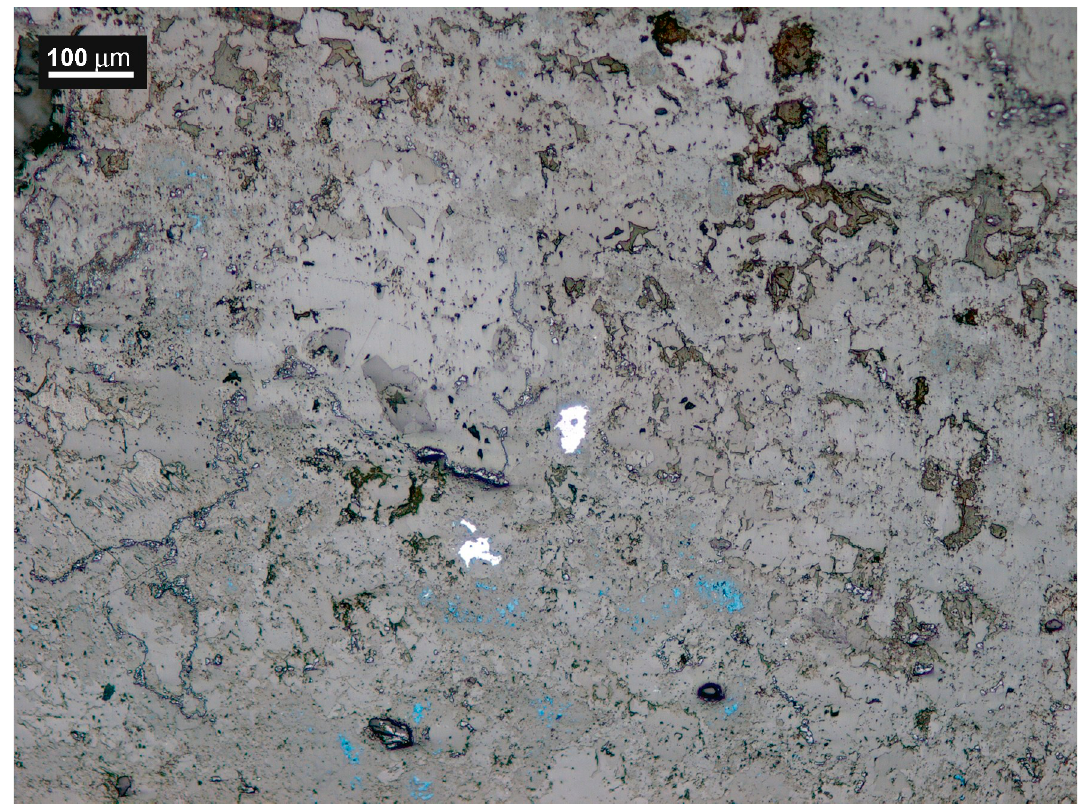
Fig 17. Blue lead sulphide in the lump Bleje ş ti 1–2, near galena inclusions. OM, bright field (S. Rovira).